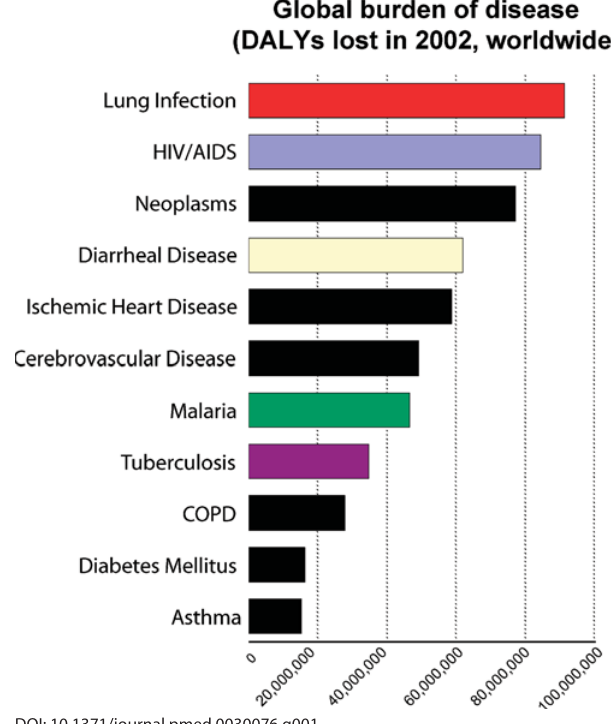
Figure 1. The Global Burden of Selected Diseases in 2002, as Measured by Disability-Adjusted Life Years (DALYs) Lost